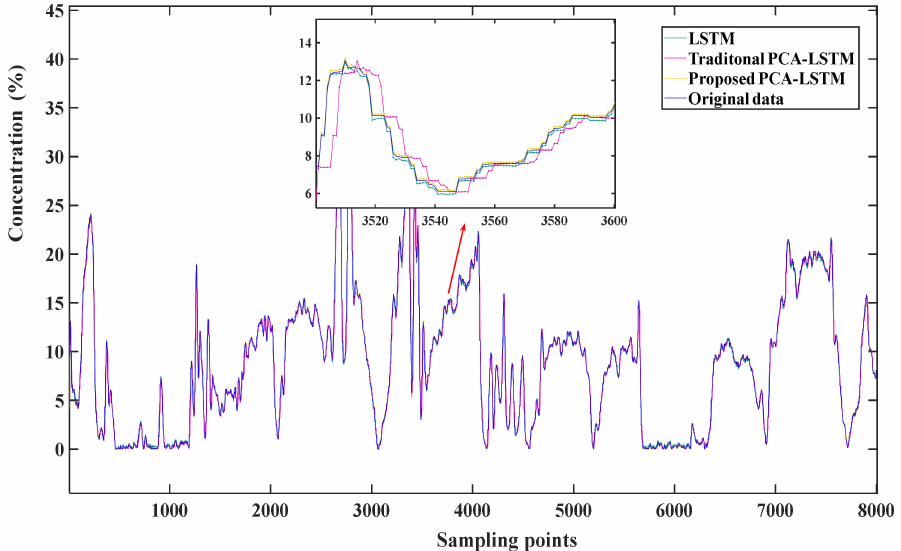
Figure 12. The training result of comparative